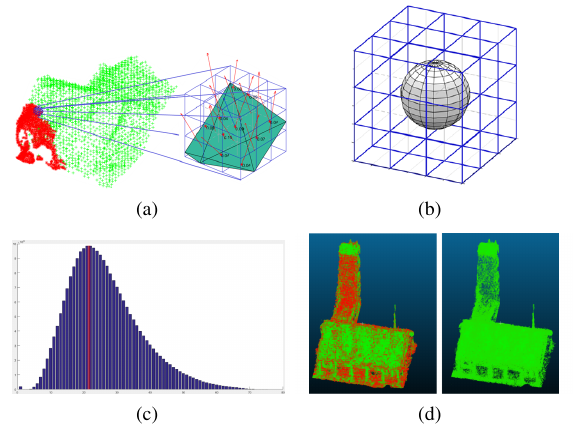
Figure 1. Voxel-based noise removal (a) Surface approximation using PCA (b) Neighborhood and sphere around the kernel for the fast cell intersection test (c) Sample point-to-surface distance histogram (d) Sample cloud showing the removed points in red groups to form fac¸ade fragments of the same orientation. This is achieved by pair-wisely comparing the line directions of the cells within the local 8-neighborhood and the line direction of the cen- ter element against a fixed angular threshold. In case of match- ing directions the respective cells are added to the same cell set. When no more adjacent cells are left to be assigned a common re- gression line will be estimated through the point set of each cell group. The resulting linear fac¸ade fragments will be intersected if their endpoints are locally adjacent within the grid forming a closed two-dimensional building contour. Similarly, the rooftops get modeled by sorting the 3D points into a grid keeping the z coordinates this time. Cells outside the polygonal outline from fac¸ade detection get discarded, and regression is performed for each grid element obtaining plane segments. Roof cells are iden- tified by applying a smoothness threshold and get merged into the same labeled cell group if their normals roughly point into the same